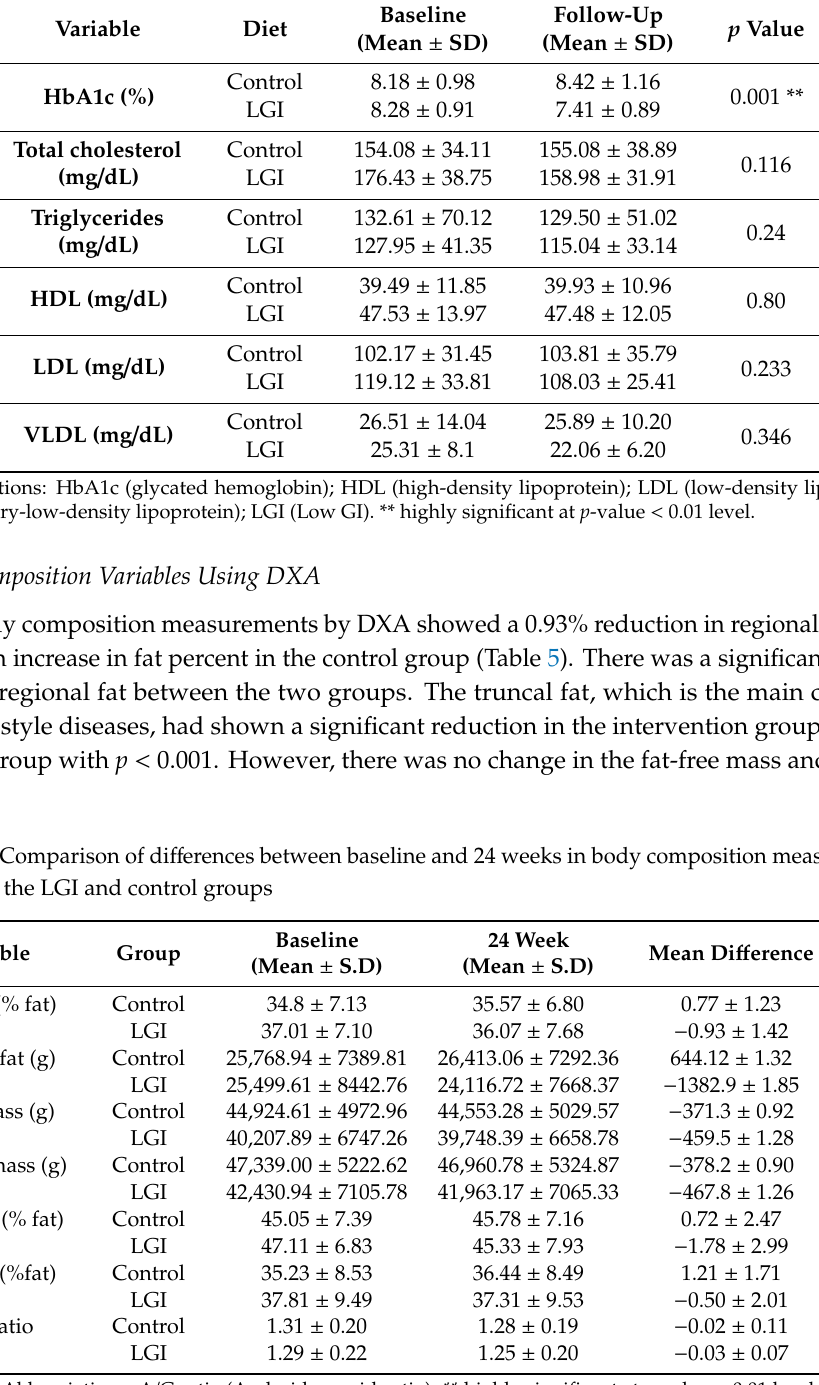
Correlations: The correlation between BMI and body composition is shown in Figure 1. There was a strong positive correlation between BMI and android fat (r = 0.745)**, total fat mass (r = 0.661)**, total truncal mass (r = 0.821)** and truncal fat (r = 0.707)**.There was a positive correlation between waist circumference and body composition variables at p < 0.01, as shown in Table 6. However, there was no correlation between gynoid fat mass and BMI. The waist circumference also did not show any correlationwith gynoid fat